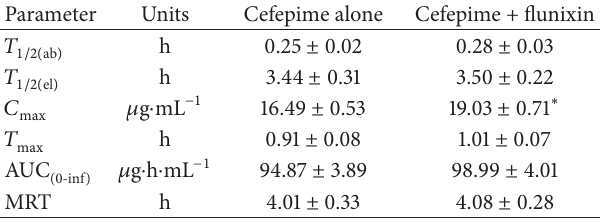
Table 2: Mean ( ± SE) kinetic parameters of cefepime (10mg/kg b.w.) alone and in combination with flunixin (2.2mg/kg b.w.) following a single intramuscular injection in goats ( n =